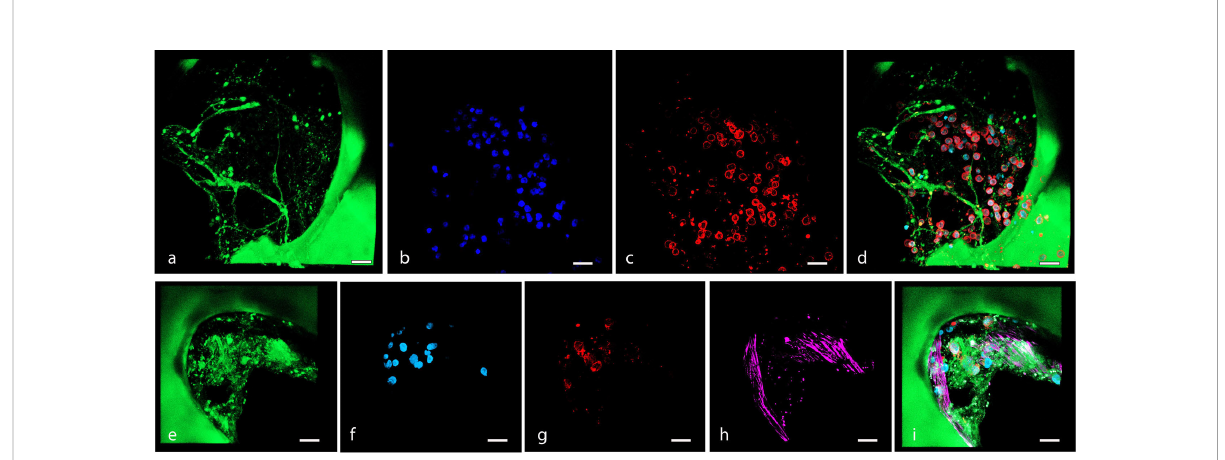
FIGURE 5 (A – D) Confocal microscopy 3D reconstruction of OCI-LY18 that adhered to the scaffold (ECM model): (A) scaffold auto fl uorescence, (B) nuclei (DAPI), (C) OCI-LY18 (CD19), and (D) merge. (E – I) Confocal microscopy 3D reconstruction of OCI-LY18 that adhered to the BM-MSC recellularized scaffold (ECM/MSC model): (E) scaffold auto fl uorescence, (F) nuclei (DAPI), (G) OCI-LY18 (CD19), (H) BM-MSC (phalloidin), and (I) merge. Scale bar: 100 m